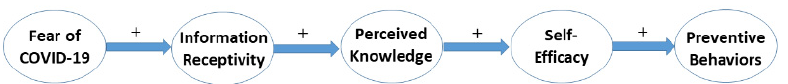
Figure 1. Sequential Mediation Model for Predicting COVID-19 Preventive Behavior.